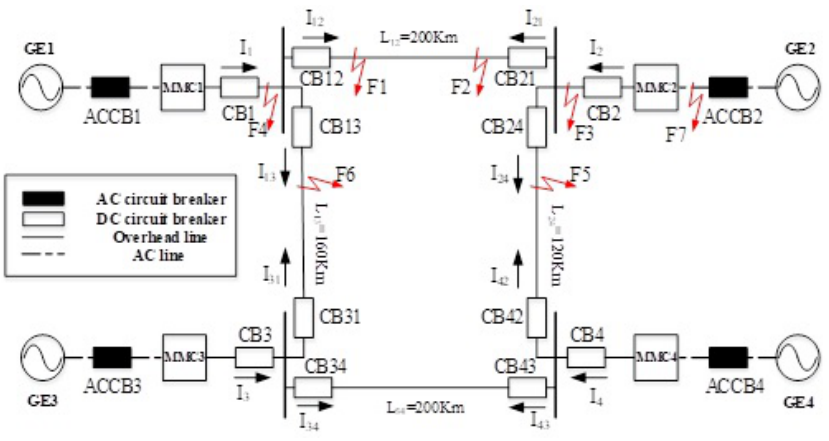
Fig. 9. Structure diagram of the four-terminal VSC-HVDC grid system Table 1. Basic parameters of hybrid DC circuit